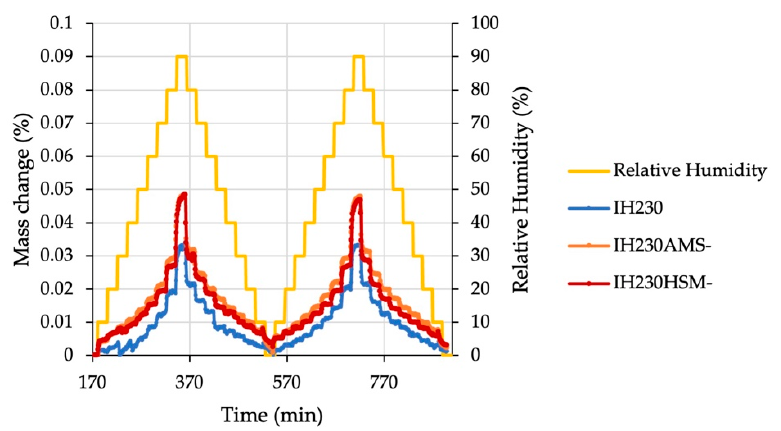
Figure 3. DVS plot showing relative mass change related to the reference mass in dependence of the relative humidity. Sample conditioning data (0–170 min) are not shown.